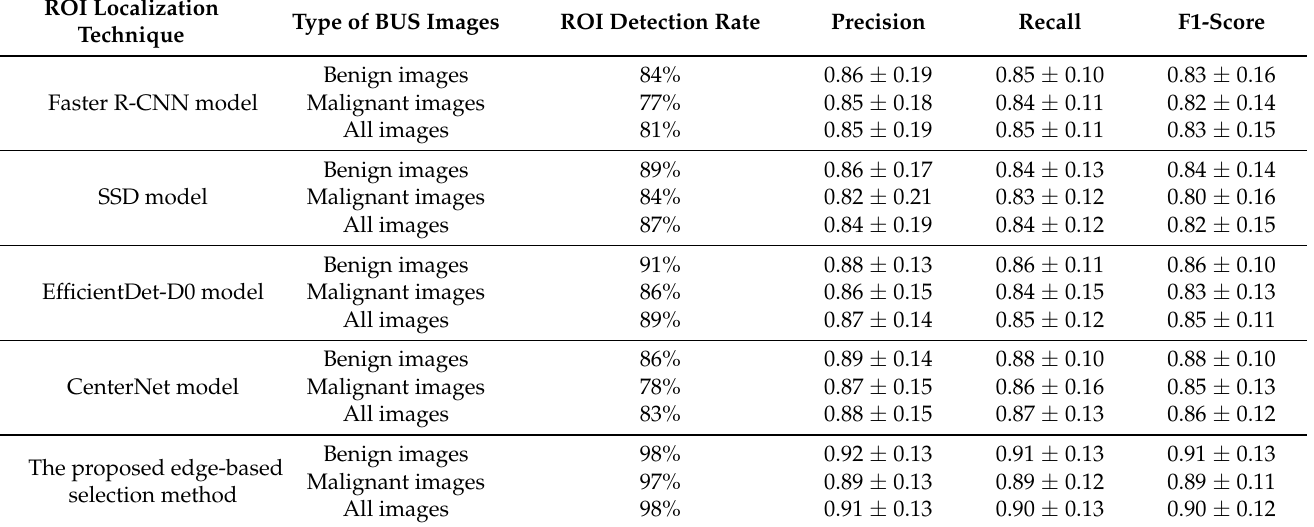
Table 2. The ROI detection rates and the mean ± standard deviation values of the precision, recall, and F1-score obtained using the Faster R-CNN, SSD, EfficientDet-D0, and CenterNet object-detection models as well as the proposed edge-based selection method based on the UJH